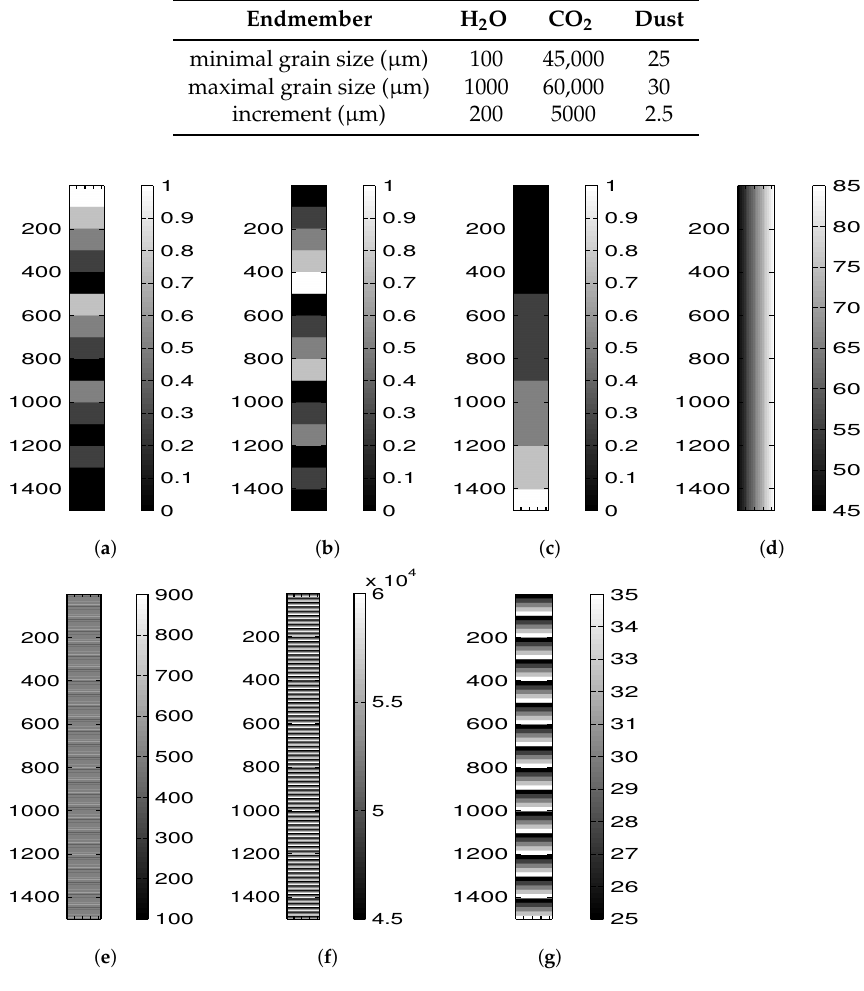
Figure 2. The spatial distribution of the parameters for simulating the synthetic data. The dimension of each image is 21 × 1500 pixels. For visualization, all the values of these parameters are normalized to [0, 255]. The scale of the parameters related to the gray values in the image are shown on the color bars to the right of each image. ( a ) Abundance of H 2 O ice; ( b ) abundance of CO 2 ice; ( c ) abundance of dust; ( d ) solar angle θ (in degrees); ( e ) grain sizes G of H 2 O ice; ( f ) grain sizes G of CO 2 ice; ( g ) grain sizes G of dust.